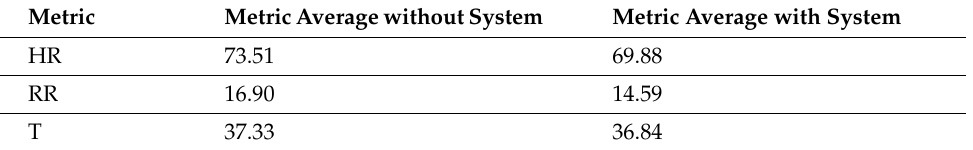
Table 4. Relationship of metrics with and without the sensor system.